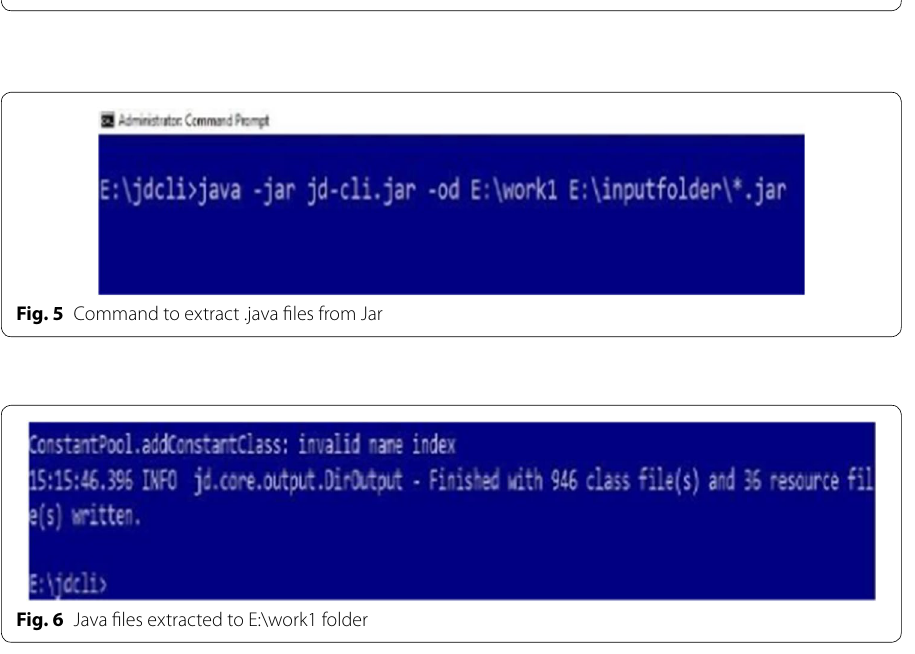
Fig. 4 Flowchart to represent implementation of Sandbox security